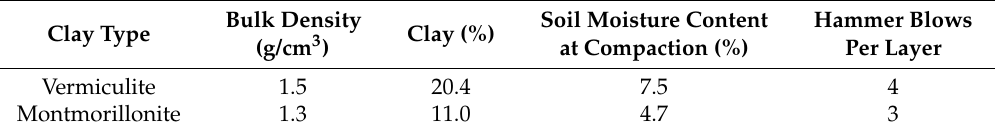
Table 2. Specifications for soil core